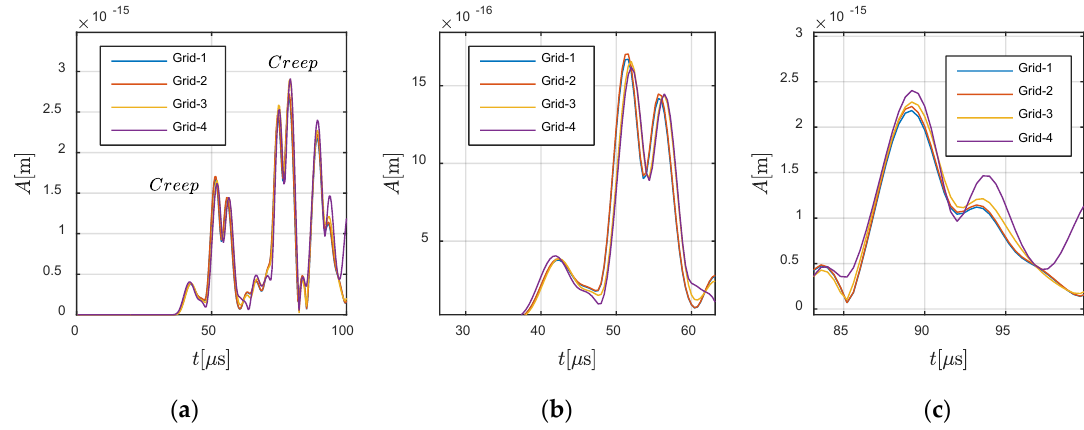
Figure 14. Responses at − 0.125 m and 0 m in the fluid region: ( a ) global view and ( b , c ) local views. The highlighted part defines the theoretical wavefront and duration of the P-wave.